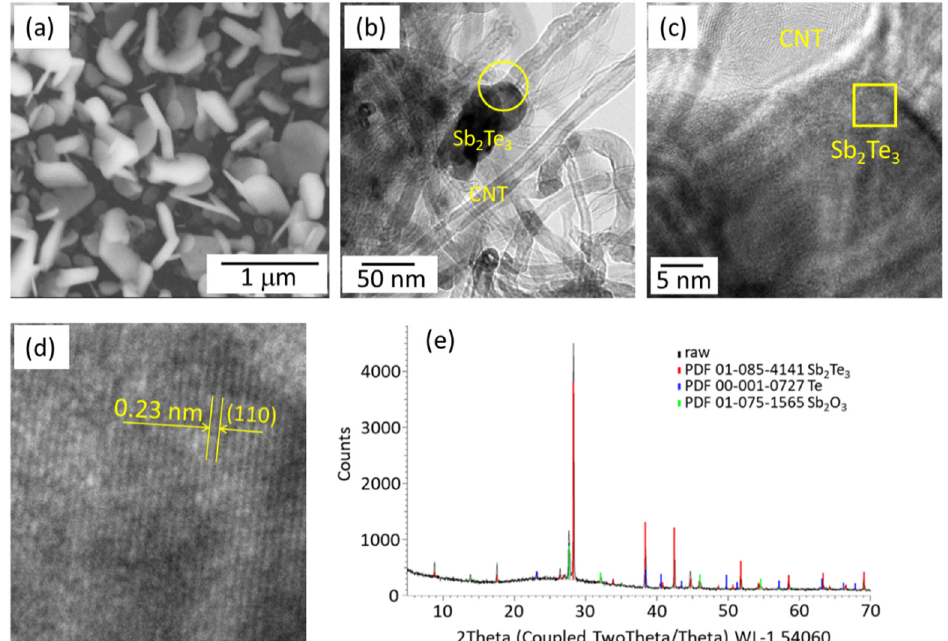
Figure 1. ( a ) scanning electron microscope image of MWCNT-Sb 2 Te 3 hybrid network; ( b – d ) high- resolution transmission electron microscope images of MWCNT-Sb 2 Te 3 hybrid network: low- magnification image ( b ), close look at the area labelled by the circuit ( c ), high-magnification image of the crystalline structure of Sb 2 Te 3 cluster in the area labeled by square ( d ), ( e ) X-ray diffraction pattern of deposited Sb 2 Te 3 nanostructures.